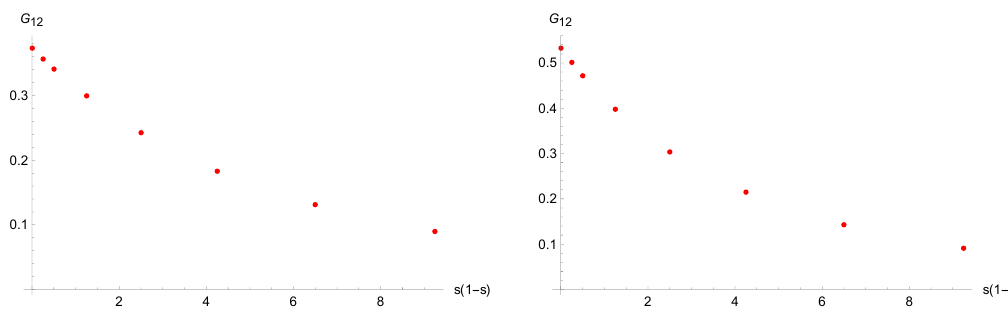
Figure 10 . Left: the 1 (cid:0) 2 correlator with m 2 = 1 ; B = 1 as a function of s (1 (cid:0) s ) (irrelevant operator). Right: the relevant case m 2 = (cid:0) 0 : 1, B = 1. They resemble the correlators of the meron wormhole and AdS 2 in that they vanish in the UV and obtain a (cid:12)nite maximum in the